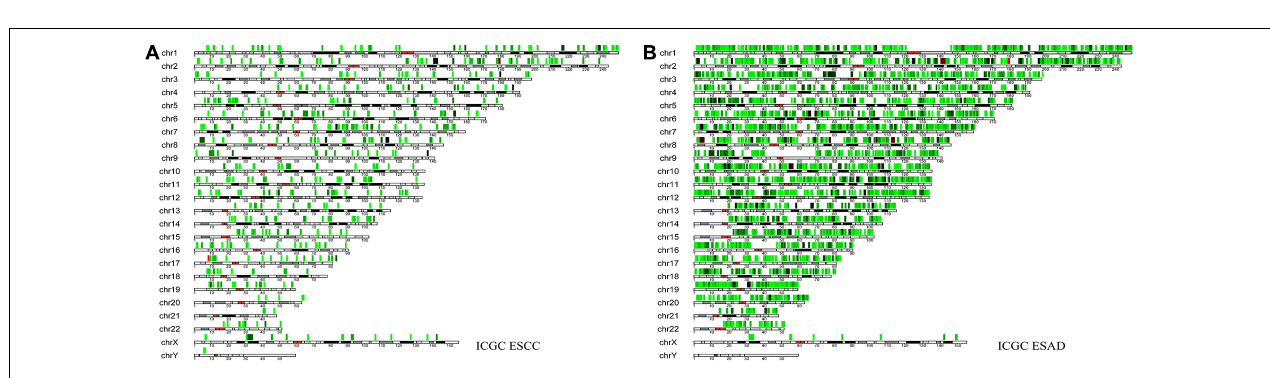
FIGURE 1 | Somatic mutation analysis. (A) Overview of somatic mutations in all samples in the ESCA TCGA cohorts. (B) Mutations in ESAD samples in the ICGC cohorts. (C) Mutations in ESCC samples in the ICGC cohorts. (D) GSEA of samples with and without TP53 mutations. Abbreviations ESAD: esophageal adenocarcinoma, ESCC: esophageal squamous cell carcinoma.